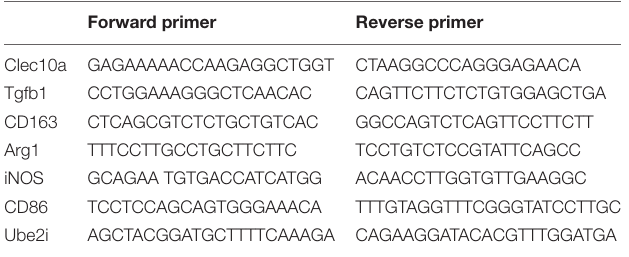
TABLE 2 | Table of qPCR primers used in the study. Forward